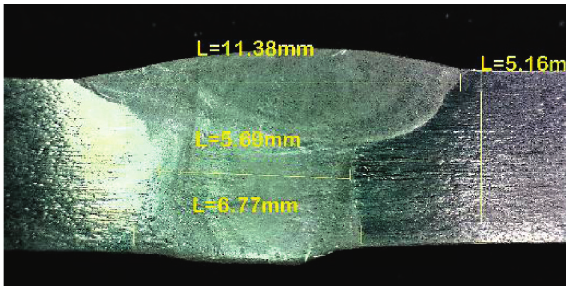
Figure 12: Weld bead geometry of the final